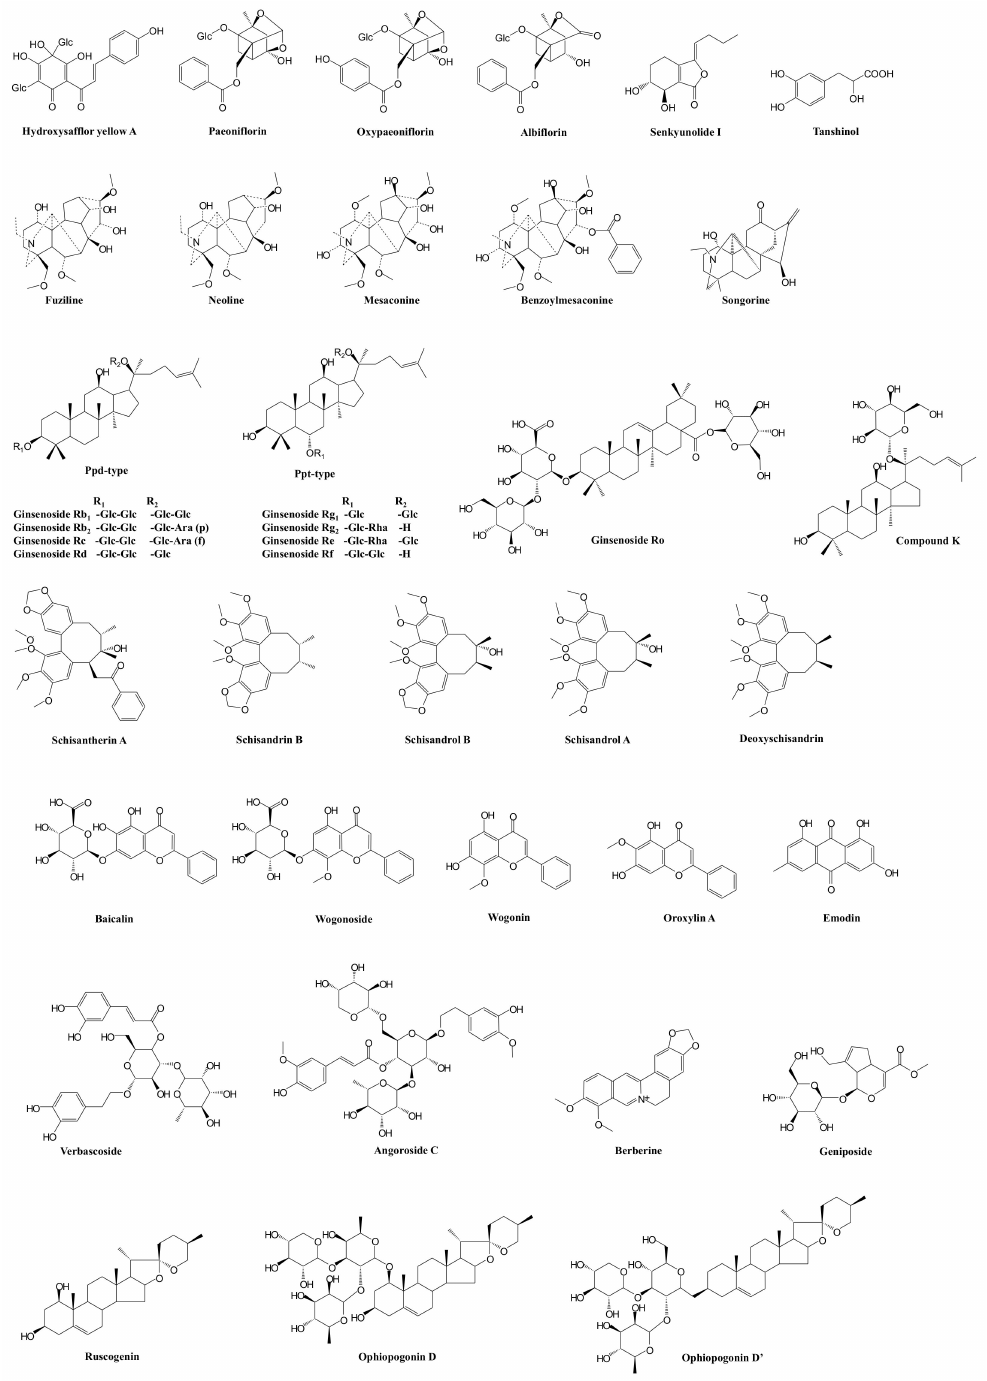
Figure 1. Chemical structures of bioactive and bioavailable herbal compounds from antisepsis Chinese herbal